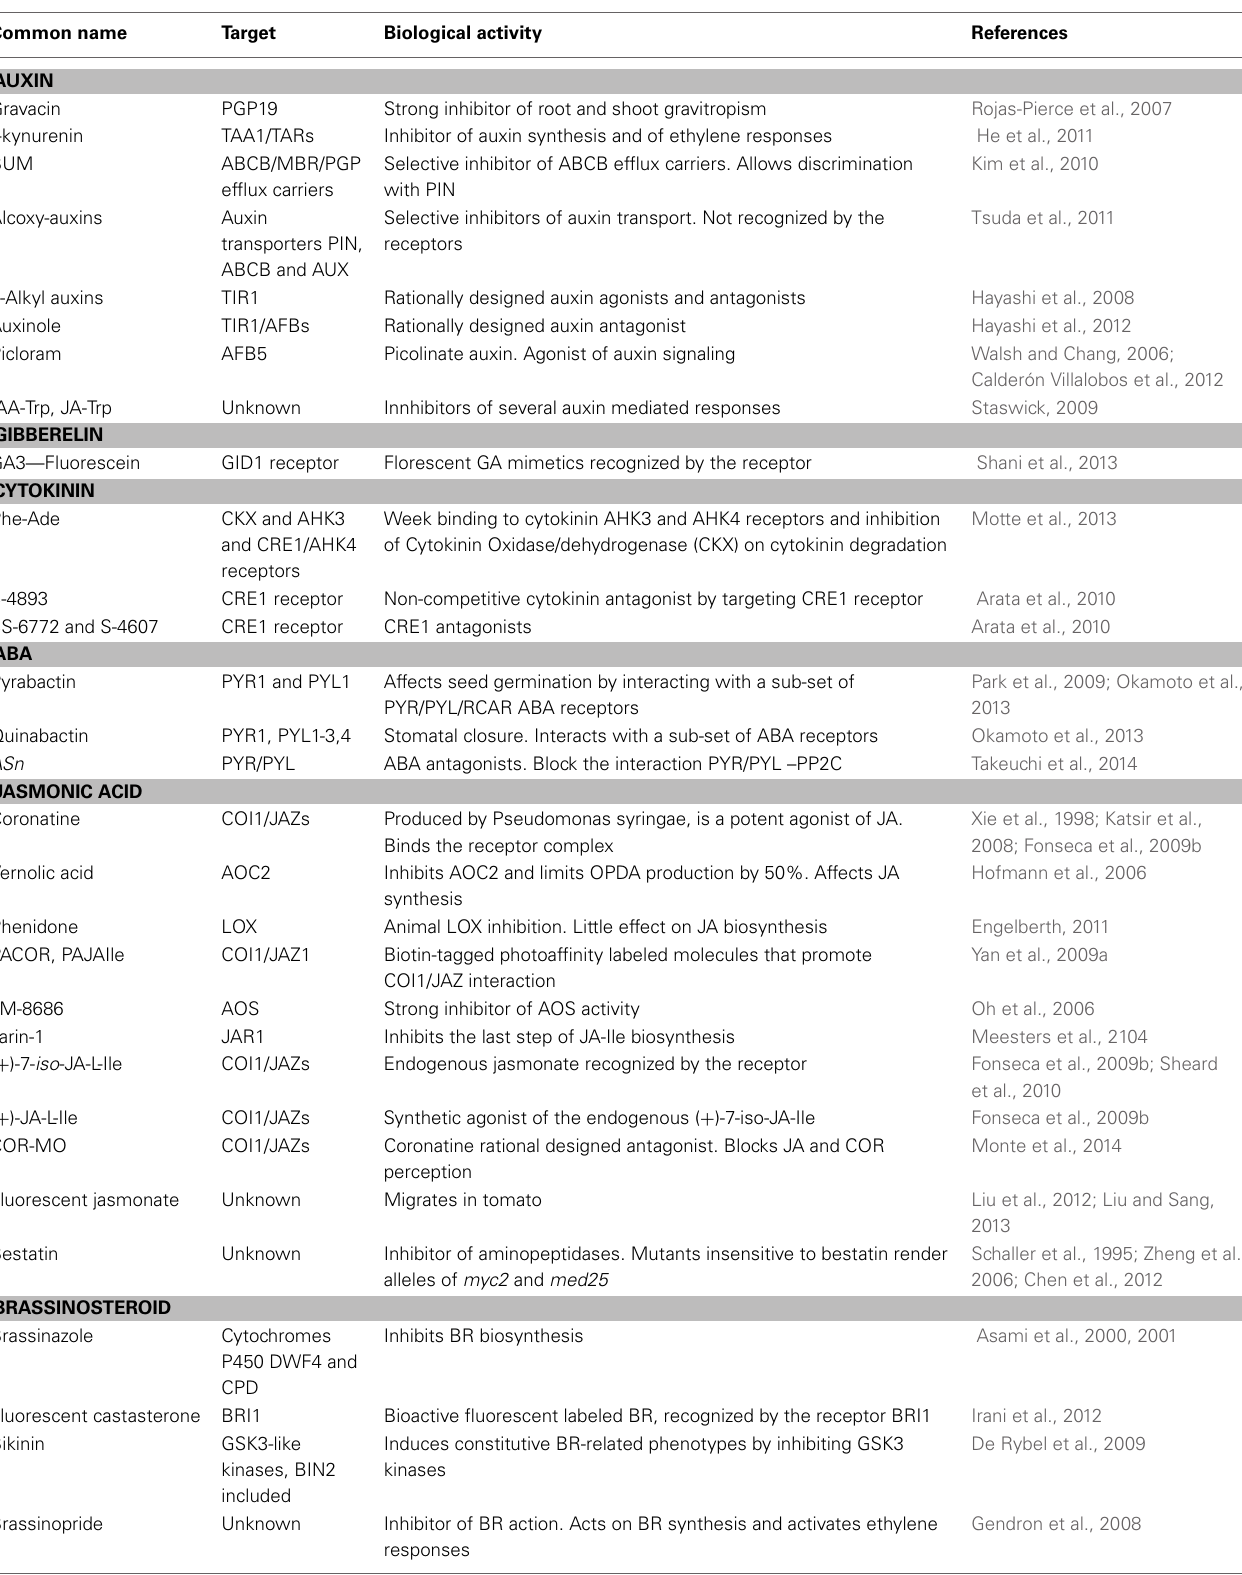
Table 1 | List of molecules described in this review including molecular targets, biological activity and